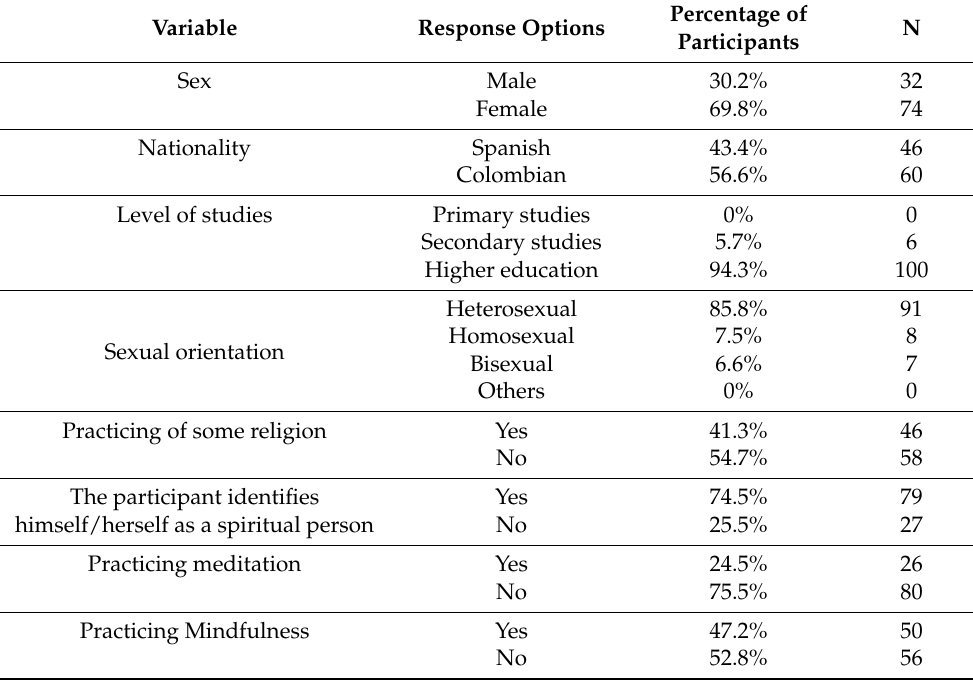
Table 1. Participants’ social-demographic